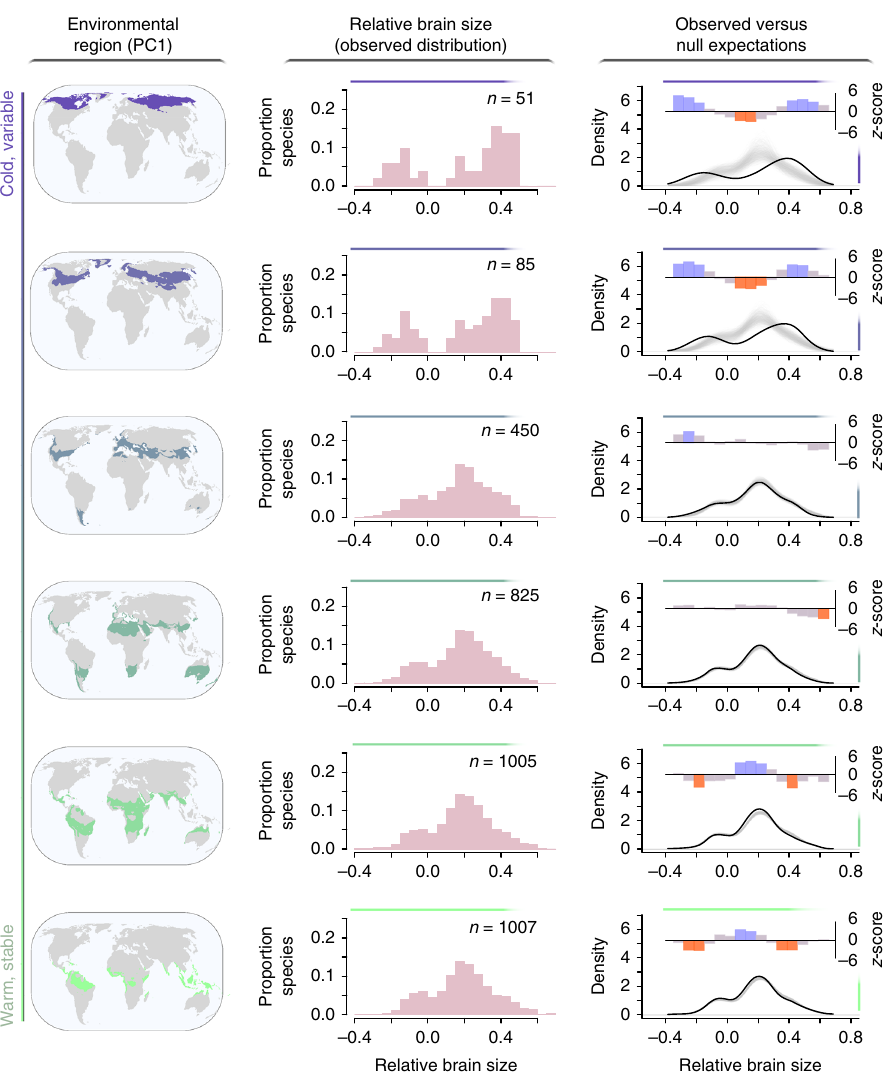
Fig. 1 The global distribution of brain size for resident birds in relation to environmental PC1. The observed distributions of relative brain size for 1280 species (middle column) within environmental bins (left column) are compared to null expectations (right column). Colored areas of maps depict the regions with conditions falling within a given window of composite environmental variable PC1 (see “ Results ” section of the text); regions of cold, seasonal, and unpredictable temperatures are in dark purple (low PC1 scores) and warm, stable regions in green (high PC1 scores) 16 . Each observed frequency distribution of relative brain size includes all species with breeding distributions that overlap with the given environmental region. Kernel density estimates of relative brain size for the observed sample of n species that occur within each environmental region (solid black lines in right column) are compared to 10,000 null density estimates, each derived from n randomly sampled species (1000 examples plotted as light gray lines). At 15 evenly spaced points across the full range of relative brain size values, empirically derived density estimates are compared to density estimates from the null samples; the height of bars in the third column depict z -scores from these comparisons. For relative brain sizes that were observed at a signi fi cantly higher than expected frequency within a given environmental region, bars are depicted in blue, those observed signi fi cantly less frequently are depicted in red, and those that do not differ signi fi cantly from null expectations are depicted in gray. Source data are provided as a Source Data fi